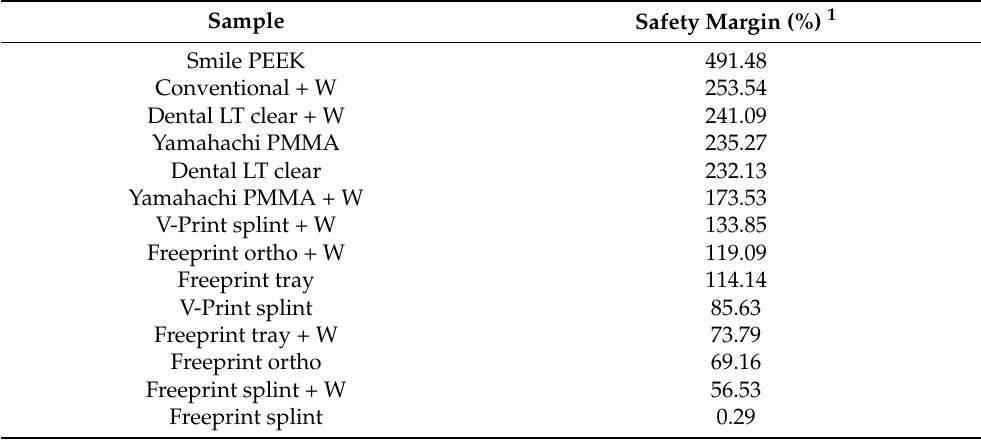
Table 4. Provided safety margins (%) for samples with (+W) and without wire from highest to